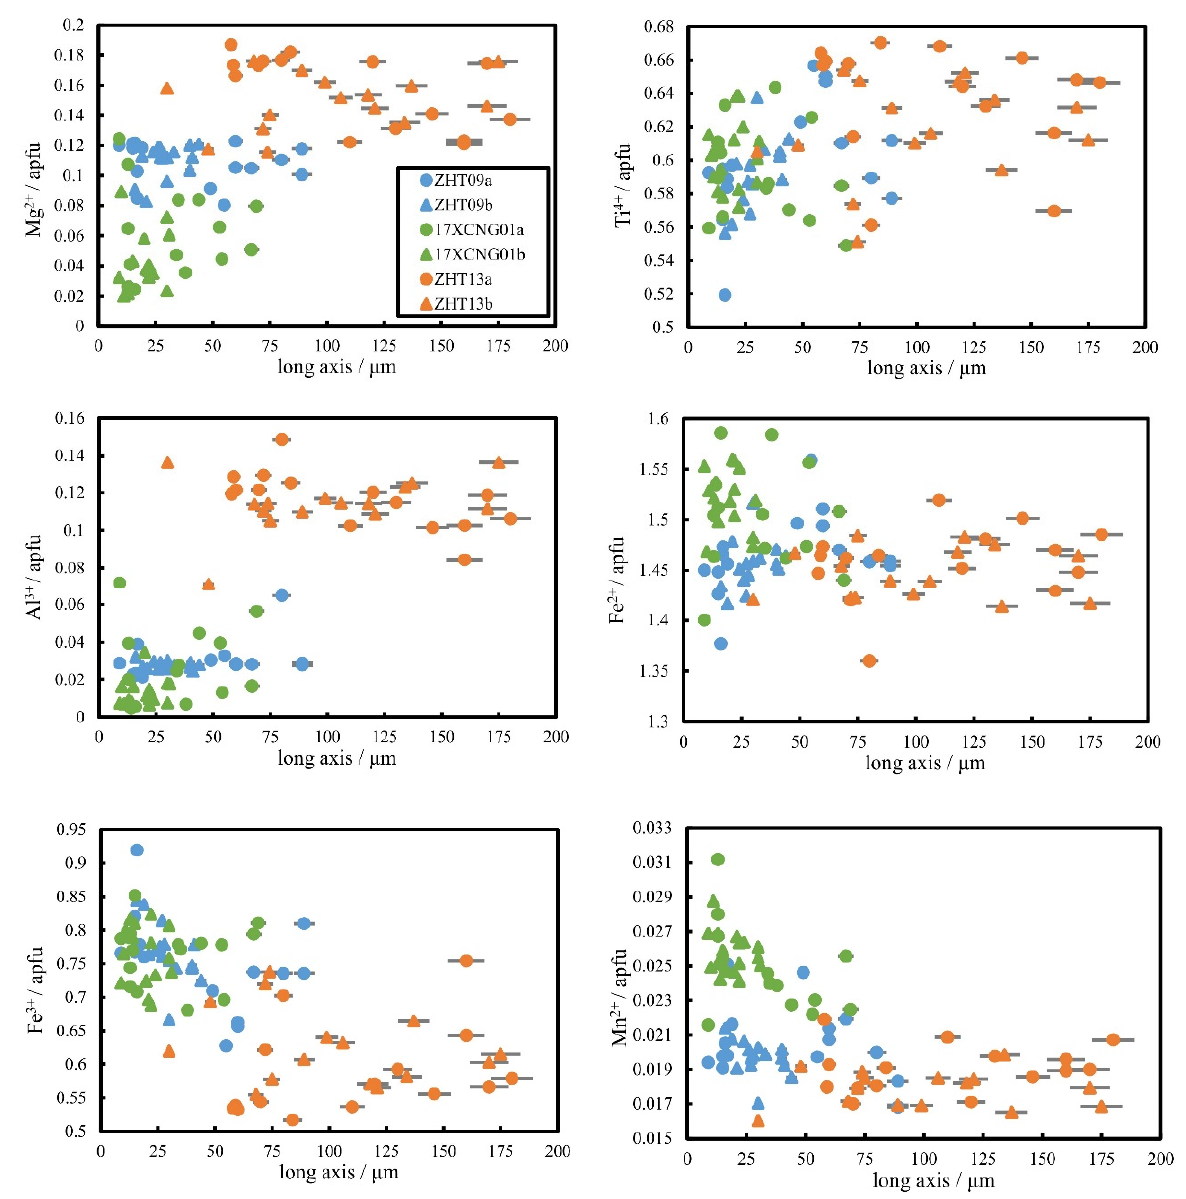
Figure 9. Relationship between major element concentrations in titanomagnetite reported by atom per formula unit (apfu) and the 2D-shape long axis of titanomagnetite in L-CSD (ZHT09 and 17XCNG01) and F-CSD (ZHT13) that was tested. The 2D-shape axis of titanomagnetite is measured by BSE images through distance measurement tools. The vast majority of titanomagnetite is round and granular, and the long axis of the section can approximately represent the particle size. The error is less than 5%. Two independent tests were conducted to obtain two sets of data (15 particles for each test), marked as ‘sample-a’ and ‘sample-b’, respectively. Some error bars smaller than the symbols are not shown.